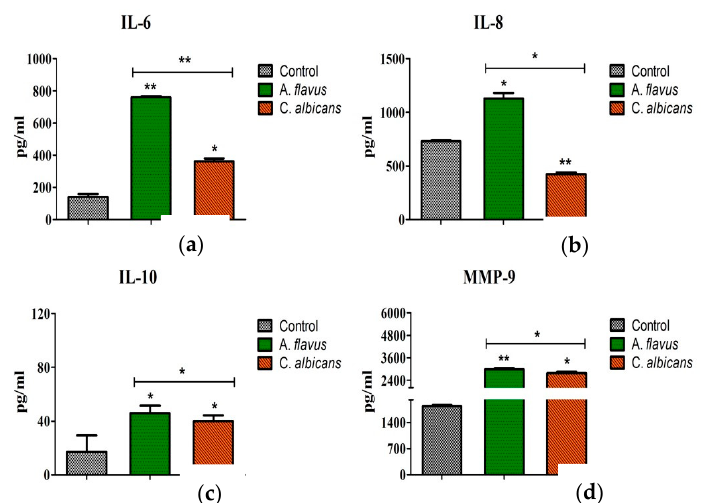
Figure 4. CHME-3 cells were infected with A. flavus and C. albicans . Production of ( a ) IL-6, ( b ) IL-8, ( c ) IL-10 and ( d ) MMP-9 were measured in cell-free supernatants after 24 h at 37 °C by ELISA. Values shown are the mean ± SE of three independent experiments performed in triplicate. Significant variations in production of cytokines and MMPs were determined by Student’s t -test. * p < 0.05, ** p < 0.005.